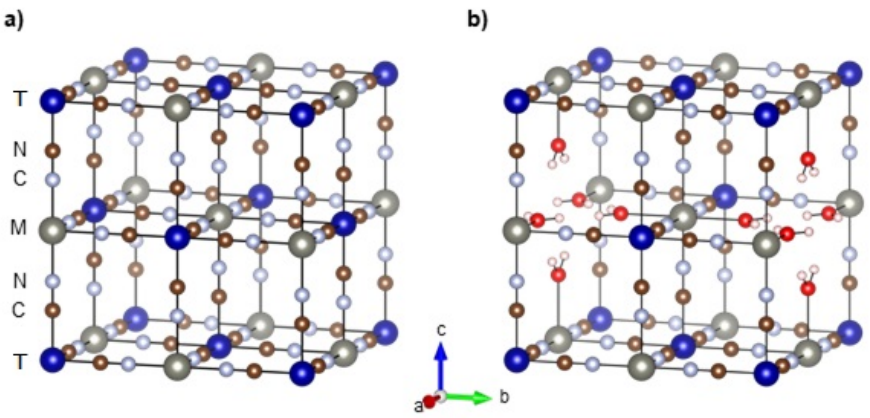
Figure 2. Crystal structure of divalent transition metal hexacyanometallate(III) compounds ( a ) without and ( b ) with [M(CN) 6 ] 3 − vacancies. Herein, six isostructural zeolite-like divalent transition metal